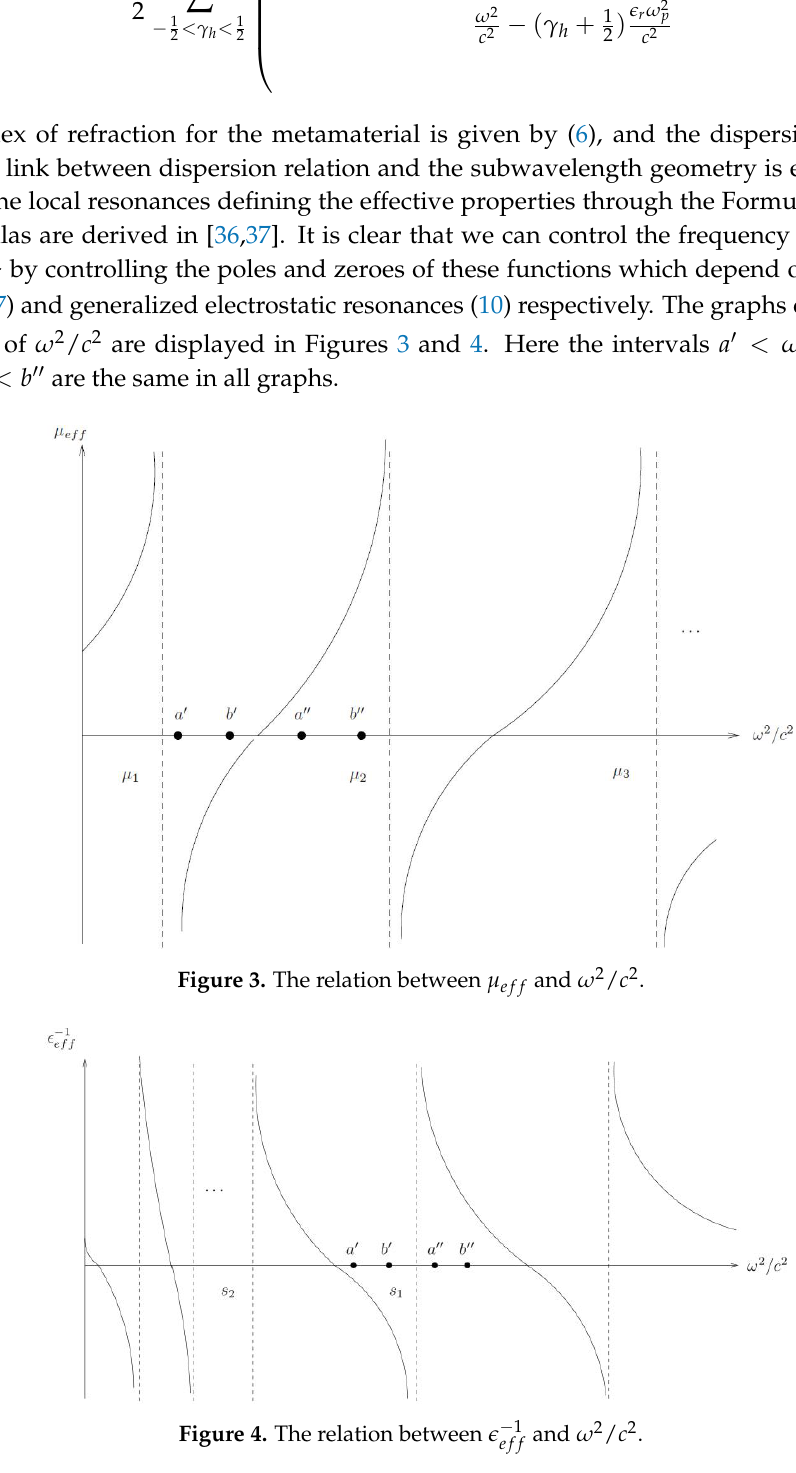
and ω 2 / c 2 ef f